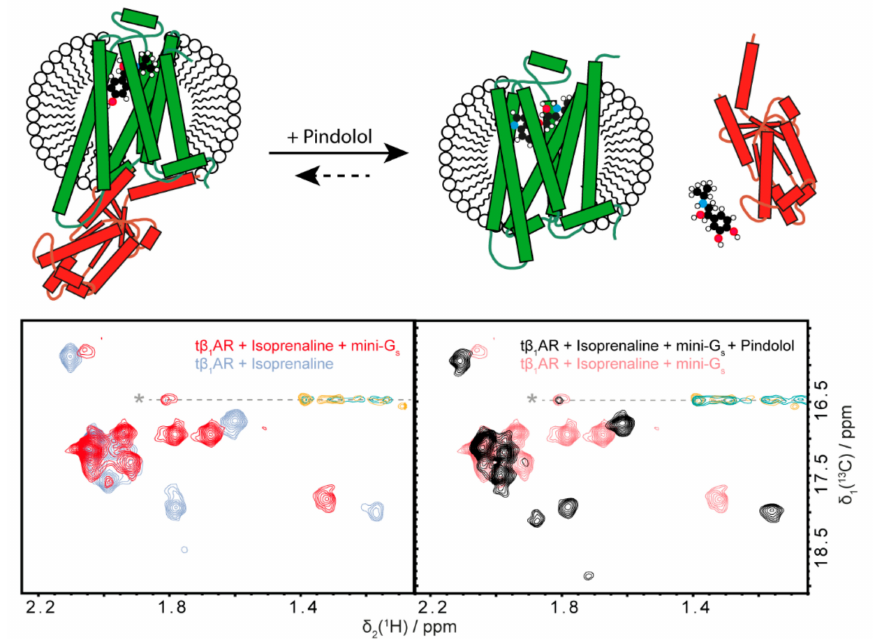
Figure 5. Pindolol can inhibit the interaction between t β 1 AR-TS and mini-G s in a competitive manner. The interaction between t β 1 AR and mini-G s (left) can be abolished by addition of the antagonist pindolol (right). The addition of pindolol causes the receptor to adopt an inactive conformation, further validating the functional state of the present protein preparation. The same conditions as in Figure 2 were used with 1 mM isoprenaline, 4 mM ascorbate and a stochiometric equivalent of mini-G s present for the G protein surrogate complex. The pindolol-bound spectrum was obtained after addition of 100 µ M pindolol to the previously mentioned